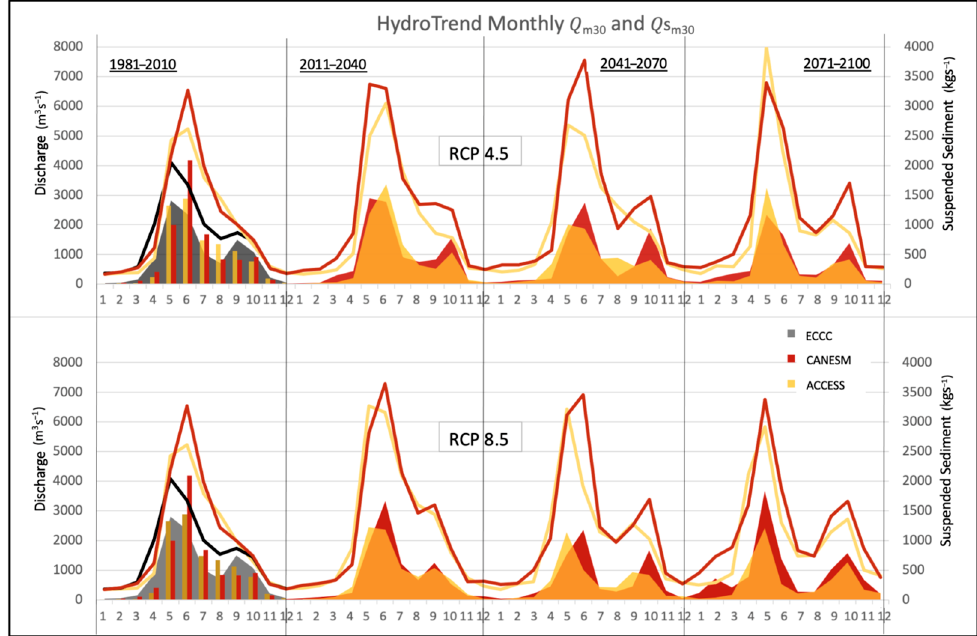
Figure 7. 30-year mean monthly Q m (lines) and Q S (shaded curves) for RCP 4.5 (top) and RCP 8.5 (bottom) scenarios for 30-year periods until 2100. Yellow curves display results of model runs using ACCESS climate forcing, red curves show model results using CANESM climate forcing, and black (Q m ) and solid grey (Q S ) curves represent model results using ECCC climate station data for the reference period.